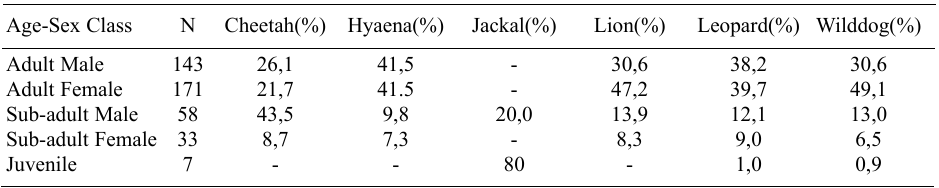
Proportional predation mortality of impala Aepyceros melampus relative to age and sex class, Letaba Ranch, Limpopo